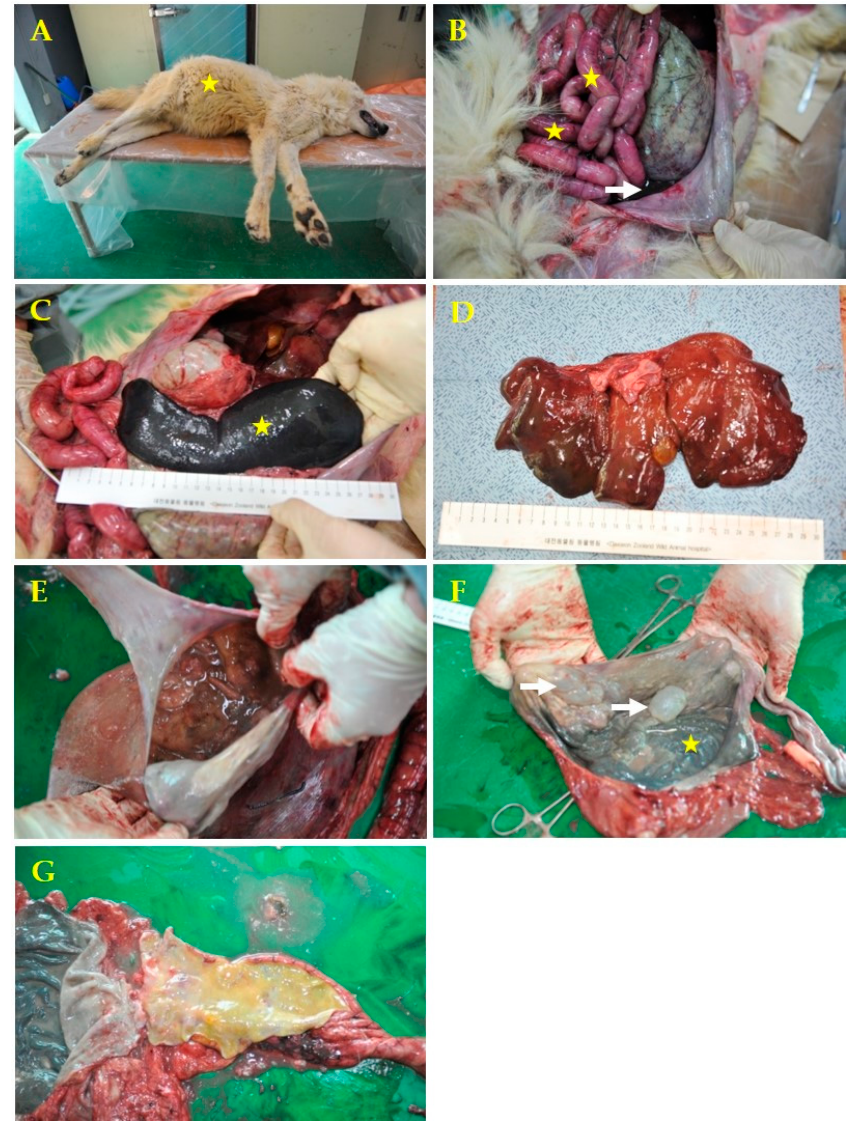
Figure 1. Macroscopic examination of systemic infection caused by Plesiomonas shigelloides in a 7-year-old male gray wolf. ( A ) Swollen abdomen (yellow star). ( B ) Swollen gastrointestinal organs, hemorrhagic congestion (yellow stars) with decaying odor, and hemorrhagic ascites (white arrow). ( C ) Severe splenomegaly (yellow star). ( D ) Decrease in the consistency of the parenchyma and mildly diffuse yellowish decolorization of the liver. ( E ) Stomach with ingested food and bad odor. ( F) The stomach membrane had a dark gray color (yellow star) and several air bubbles in the fundus (white arrows). ( G ) The intestine had yellowish watery